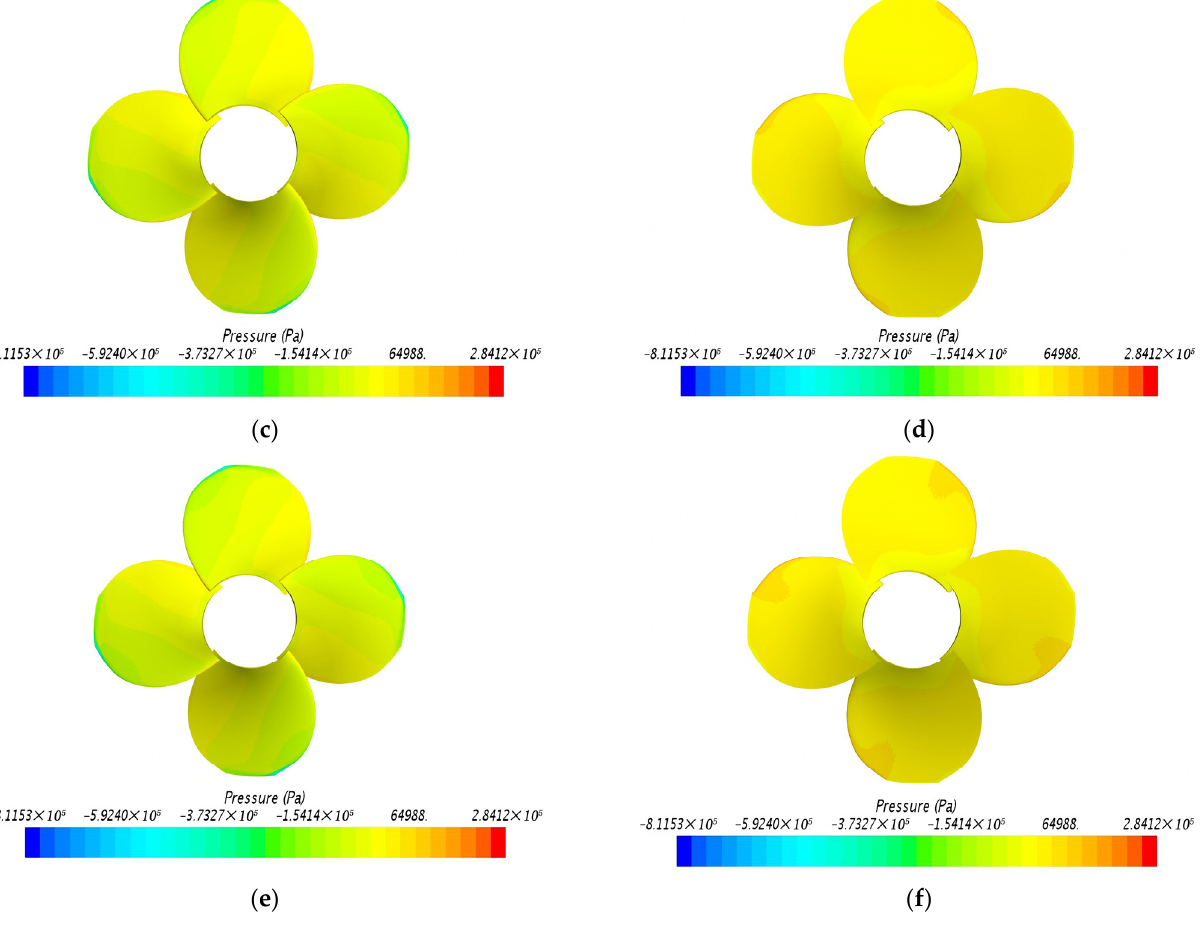
Figure 9. Pressure distribution at propeller surface. ( a ) Parent blade back pressure; ( b ) parent blade front pressure; ( c ) Optimization 1 blade back pressure; ( d ) Optimization 1 blade front pressure ( e ) Optimization 2 blade back pressure; ( f ) Optimization 2 blade front pressure.